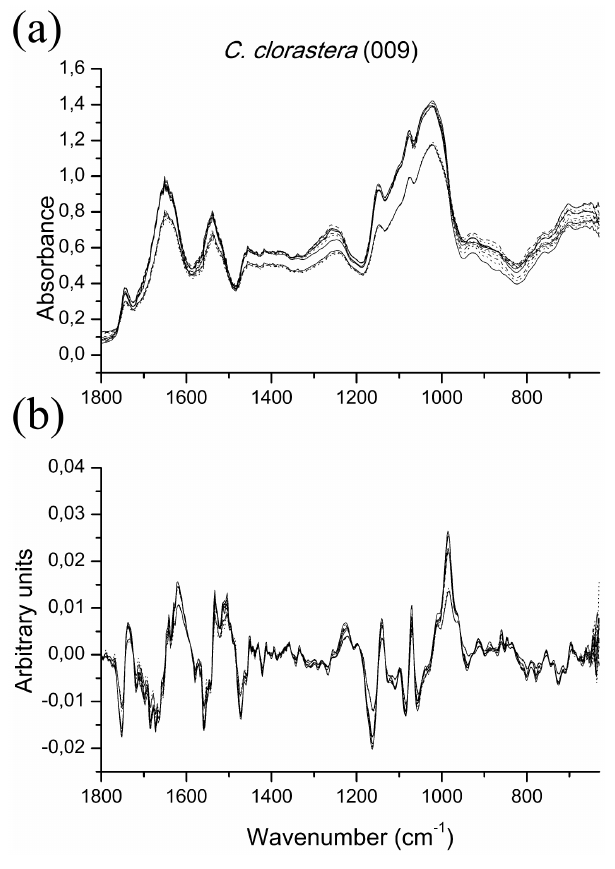
Fig. 3. Comparison of (a) raw spectra and (b) their first derivative treatment, for Chlamydomonas clorastera (009). Region shown is 1800–630 cm 2 1 for both, showing the differences from Fig. 2 and representing the similar results achieved for the strains Desmodesmus communis (030) and Coelastrum cf. sphaericum (060).